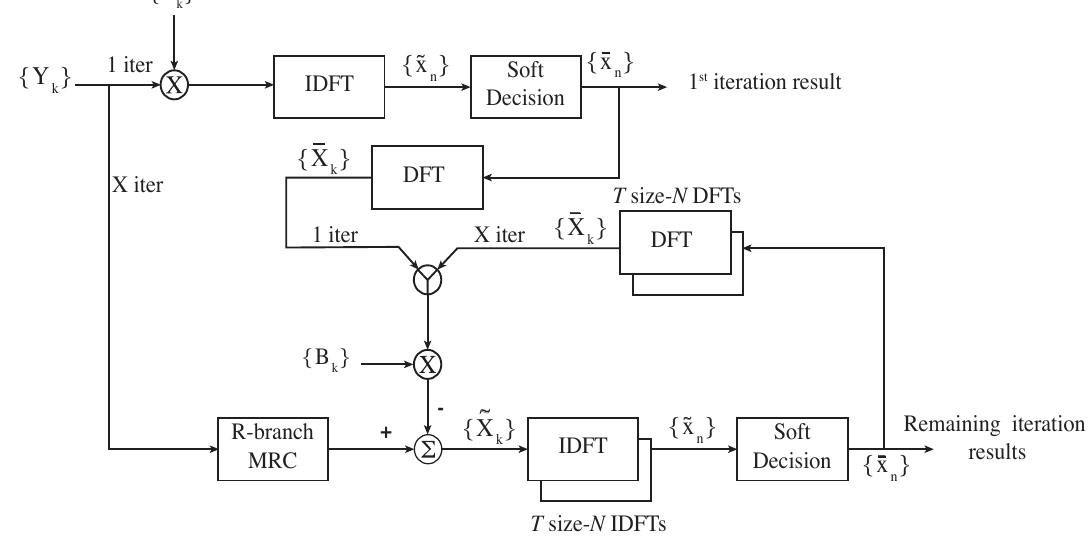
Figure 2. Iterative Block Decision Feedback Equalization (IB-DFE) receiver combined with the Maximum Ratio Combining (MRC)